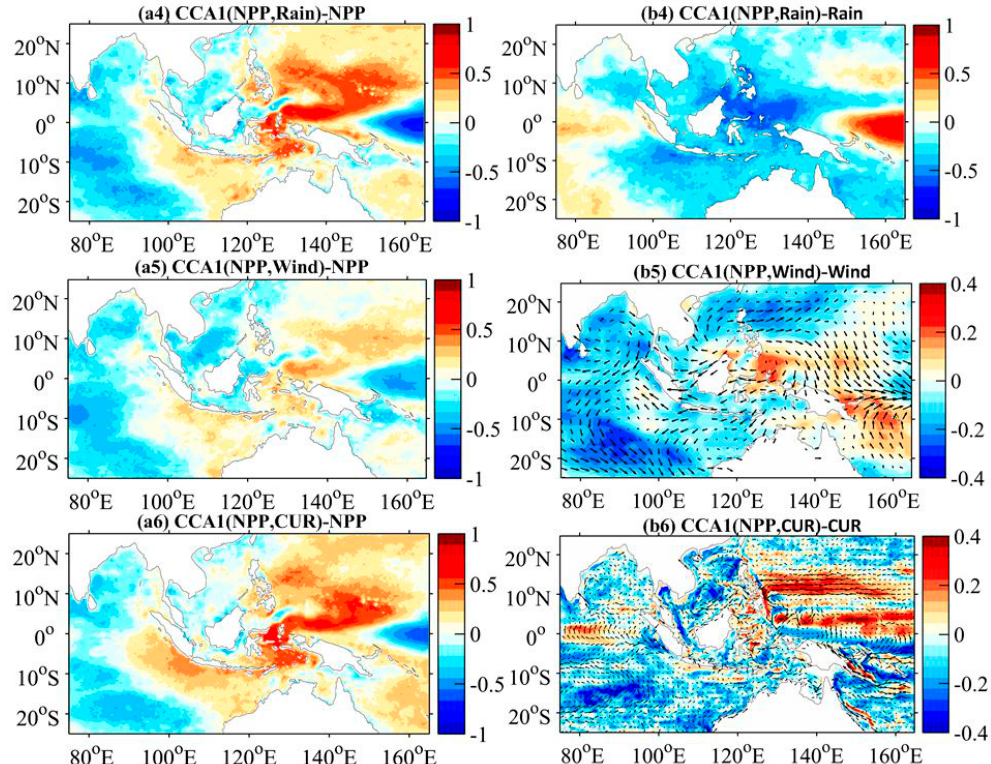
Figure 9. The canonical coupled BPCCA modes associated with ENSO. ( a1 , b1 ) spatial correlation patterns of NPP and Chla for the first canonical pair labeled as CCA1 (NPP, Chla)-NPP and CCA1 (NPP, Chla)-Chla, respectively. ( a2 – a6 , b2 – b6 ) are the same as ( a1 , b1 ) but for the modes of NPP with SST, SLA, Rain, Wind, and CUR, respectively.